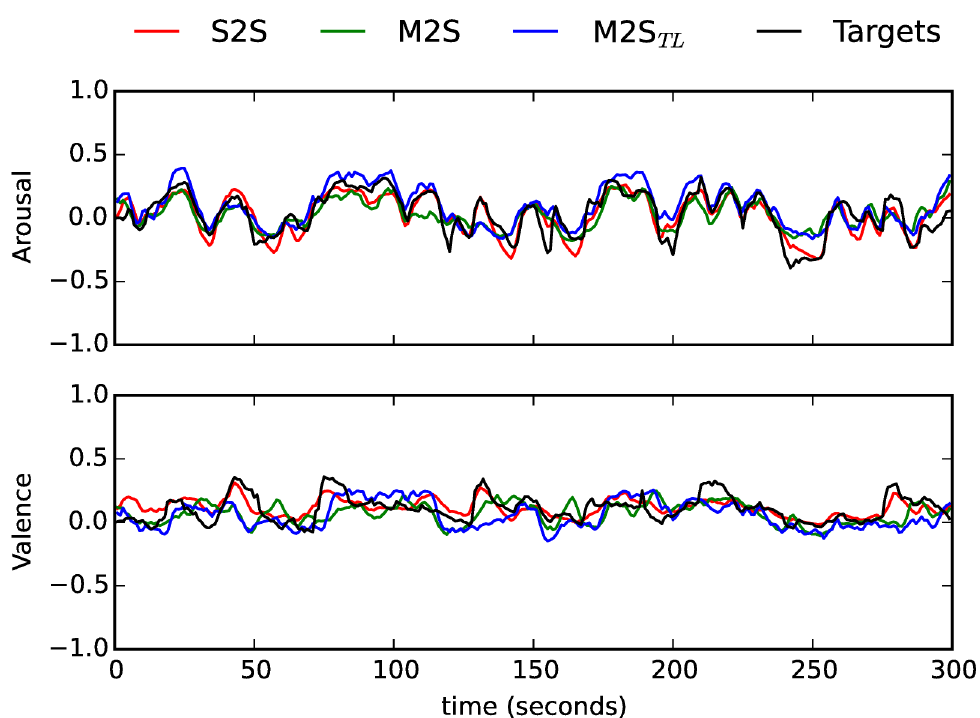
Fig 4. Time-continuous Arousal and Valence predictions by the intra- ( S ) and cross-domain ( M 2 S , M 2 S TL ) models for a RECOLA speech sample (male speaker;instance id: ‘Recola_P26_GRP13_2_HQ’). The goldenstandardis also shown